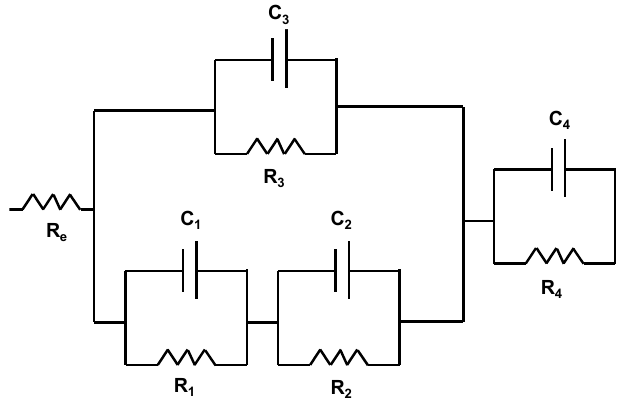
Figure 7. Electrical equivalent circuit model used to simulate EIS data for the PMMA + SiO 2 coatings.